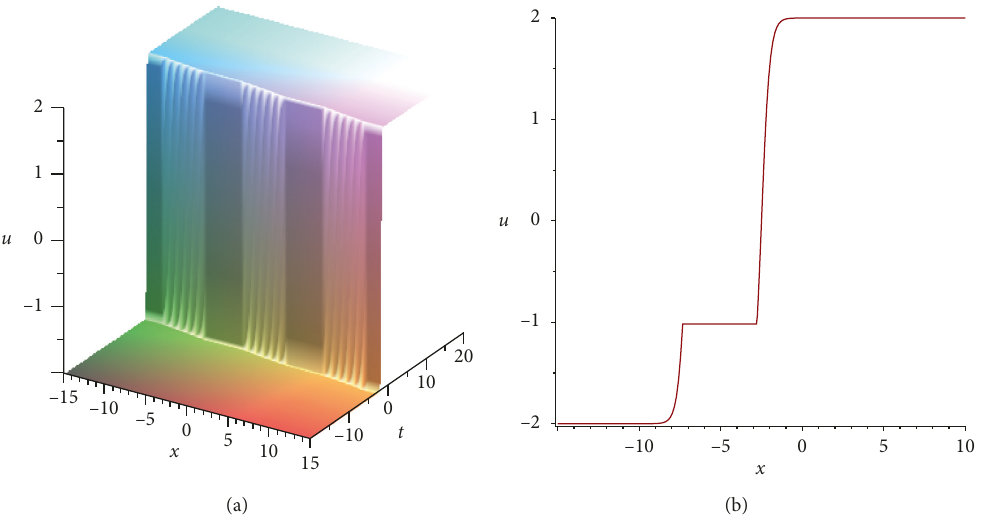
Figure 4: The interaction solution (39) with equations (50) (in Section 4.2) and the parameters are fixed by (54): (a) the three-dimensional plot; (b) the two-dimensional plot with t (cid:29)